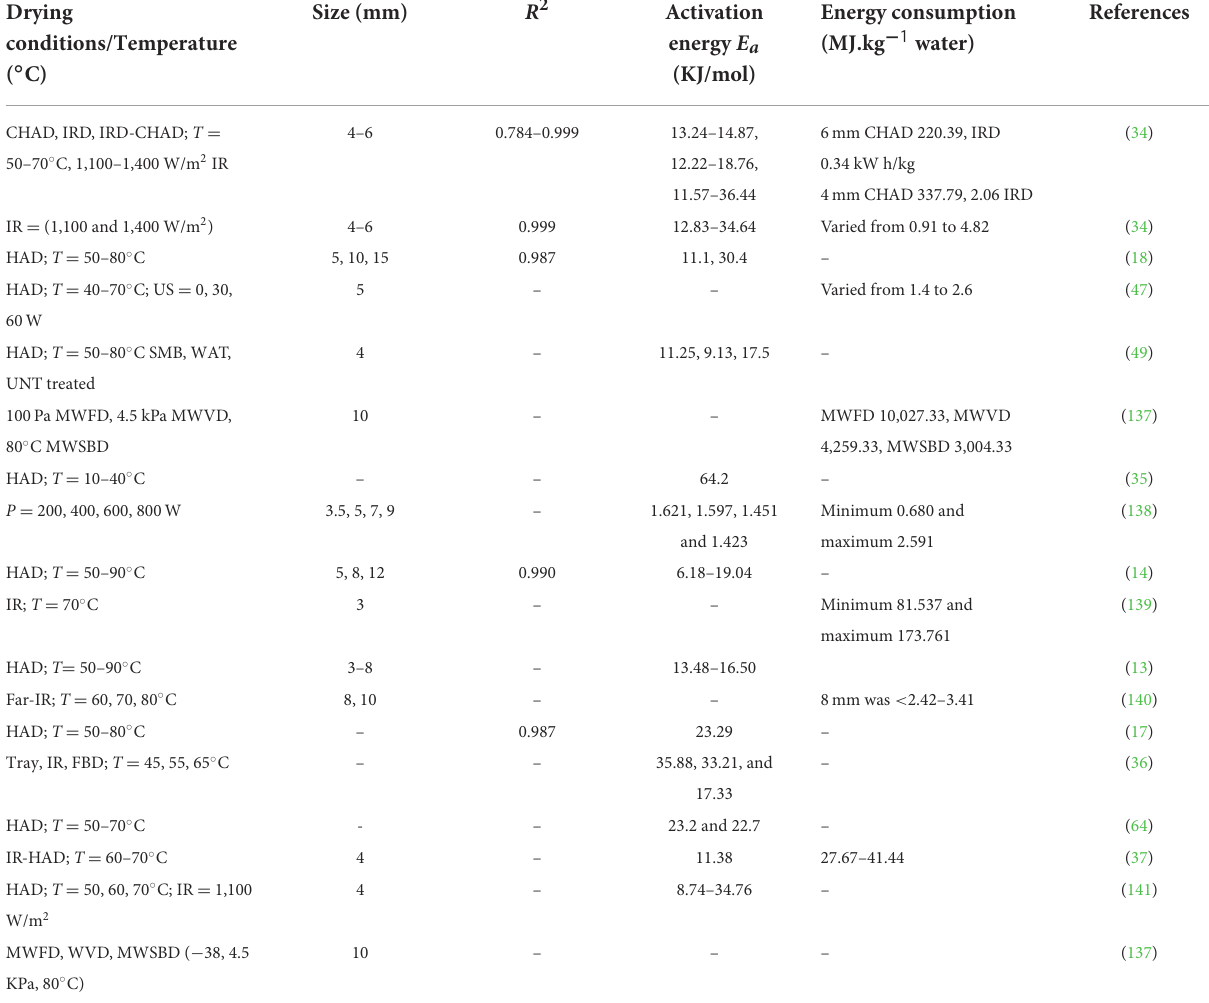
TABLE 6 Activation energy and energy consumption summarized from previous studies for sweet potato drying. Drying